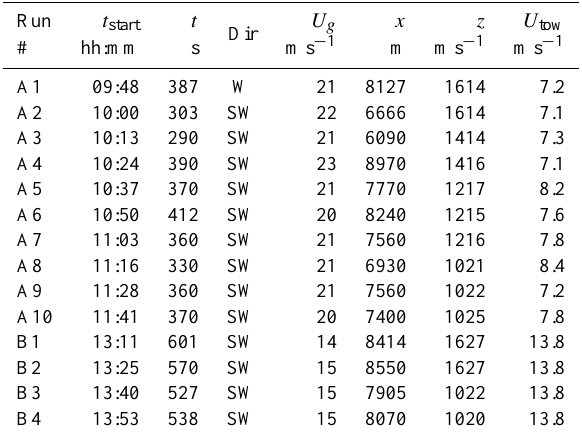
Table 1. Properties of straight and level southwesterly runs during Fts A&B with t > 300. Showing start time ( t start ), duration t , Direc- tion, surface velocity U g , horizontal length x , altitude z , and corre- sponding windspeed, U tow , measured during the run at the NOAA tower.